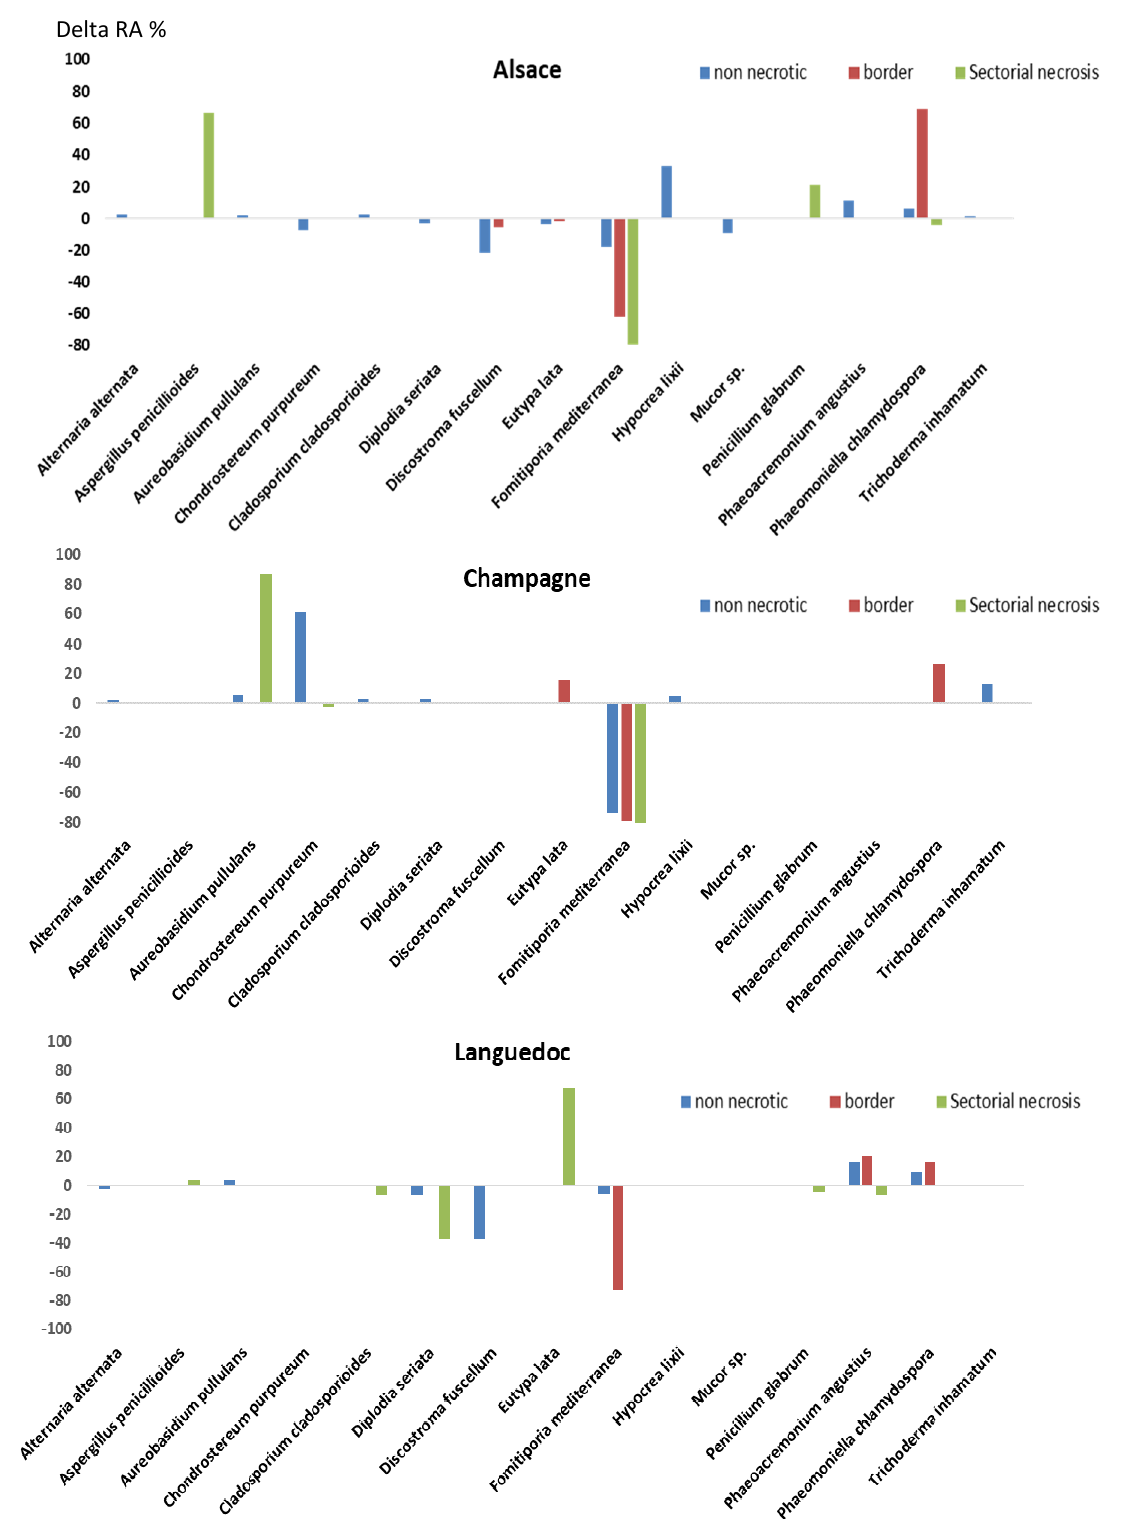
Figure 3. Differences in relative abundance of fungal species between grapevines treated or not by sodium arsenite. Data obtained from fungal ITS1 metabarcoding of samples from 2014. %: percentage of OTU reads for a given sample relative to the total number of reads for this OTU. Differences in relative abundance (%) between treated and untreated grapevines (0: no difference, +100%: increase by 100% after treatment, − 100%: decrease by 100% after treatment). Non-necrotic (blue), border (red), and white-rot necrosis (green) woody